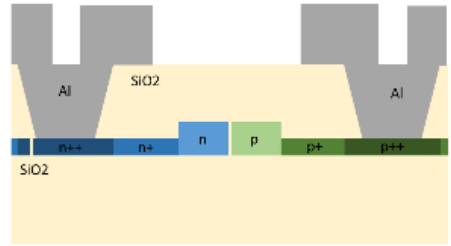
Fig. 1. Cross-section of the MOSCAP